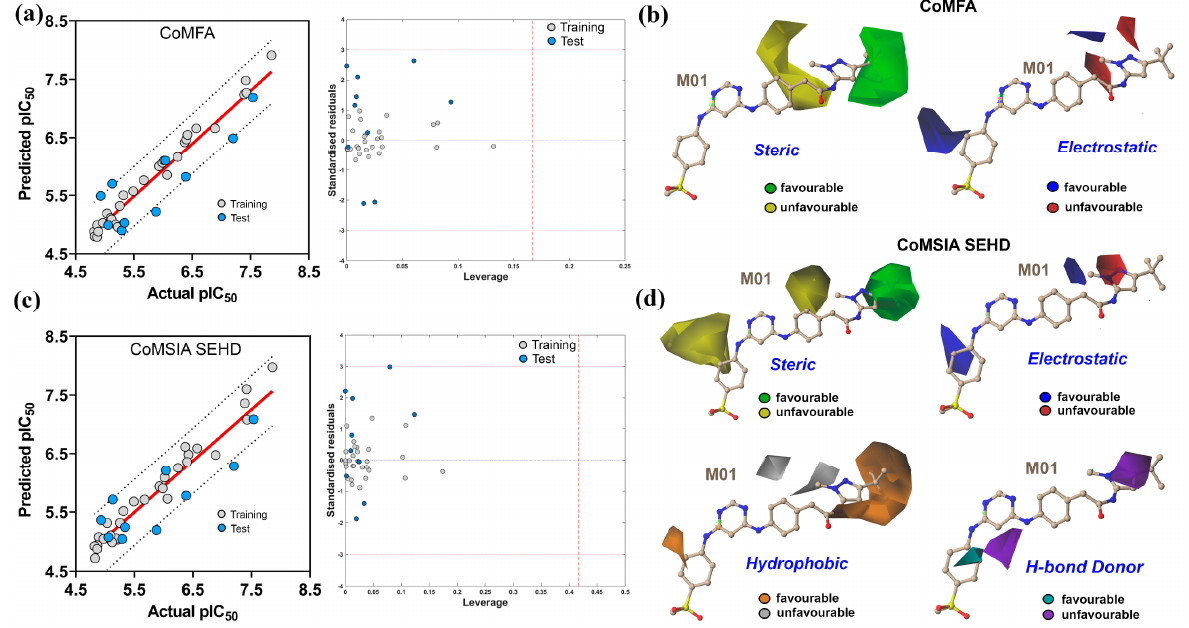
Figure 8. PLS scatter plot, Williams plot, and CoMFA-CoMSIA contour maps analysis. ( a ) Scatter plot of actual vs. predicted pIC 50 values from the CoMFA and the corresponding Williams plot for AD analysis. ( b ) The green and yellow contours from CoMFA indicate the favorable and unfavorable substitution for the steric groups. The blue and red contours indicate the favorable and unfavorable positions for the electropositive groups. ( c ) Scatter plot of actual vs. predicted pIC 50 values from the CoMSIA and the corresponding William’s plot for AD analysis. ( d ) From CoMSIA, green and yellow contours signify the favorable and unfavorable positions for the steric group, whereas the blue and red contours show the favorable and unfavorable substitutions for electropositive groups. The orange and gray contours show the favorable and unfavorable positions for the hydrophobic groups. The cyan and purple colors signify the favorable and unfavorable positions for the H-bond donor